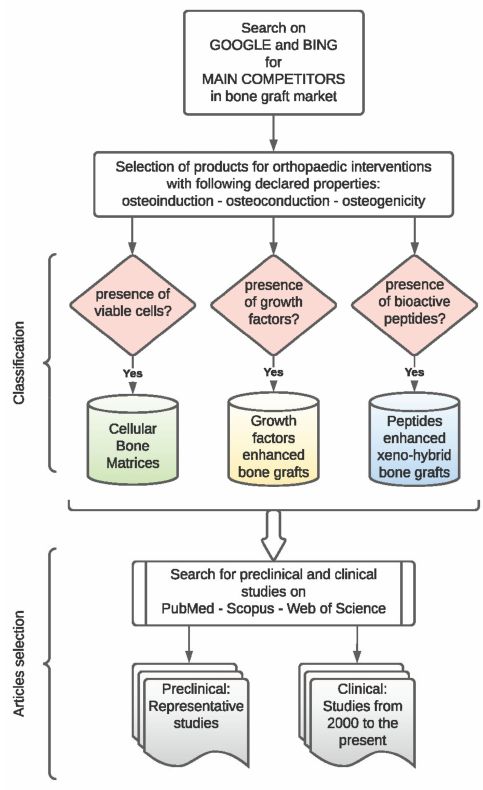
Figure 1. Flowchart showing product classification and study